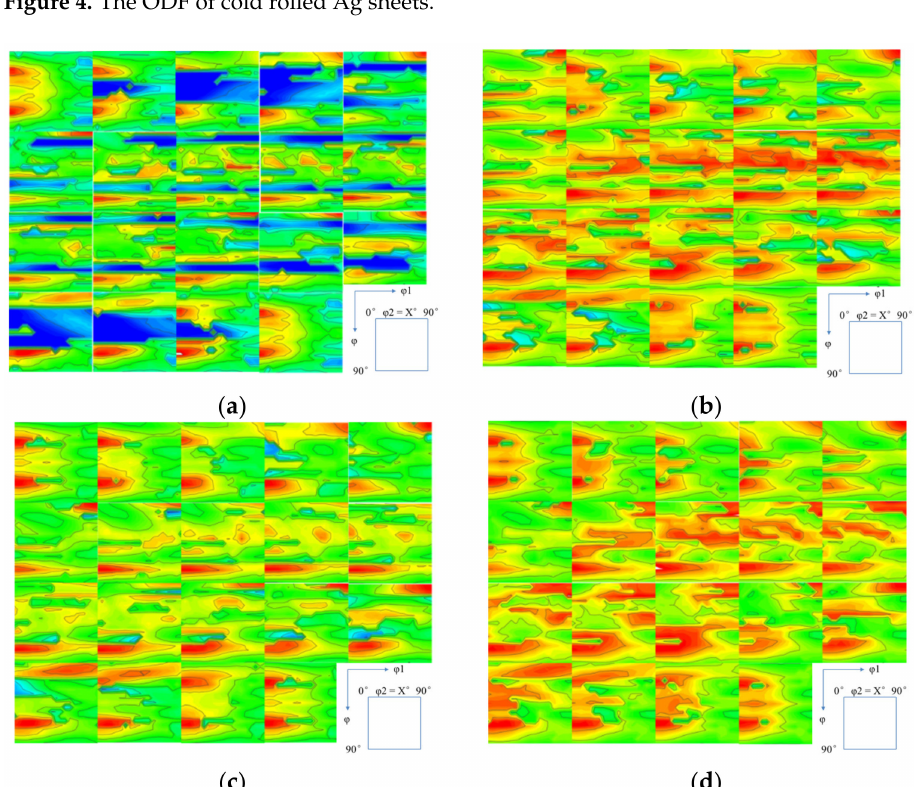
Figure 5. The ODFs of Ag sheets cold rolled and followed annealing at 300 ◦ C ( a ), 400 ◦ C ( b ), 500 ◦ C ( c ), 600 ◦ C ( d ),